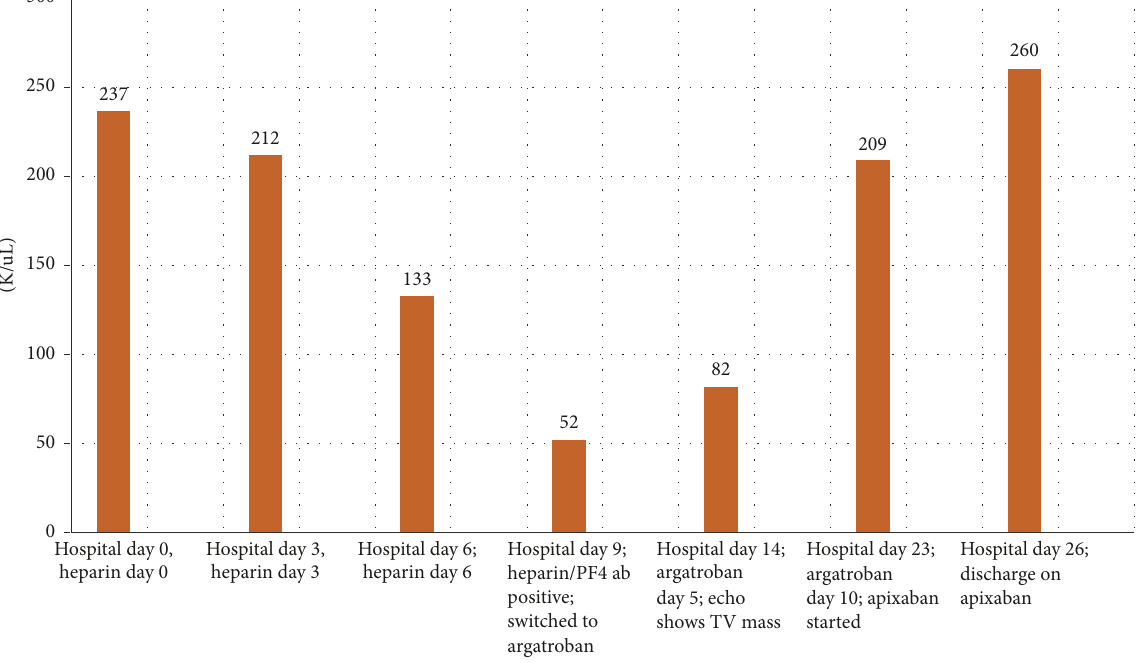
Figure 1: Timeline of platelet counts.